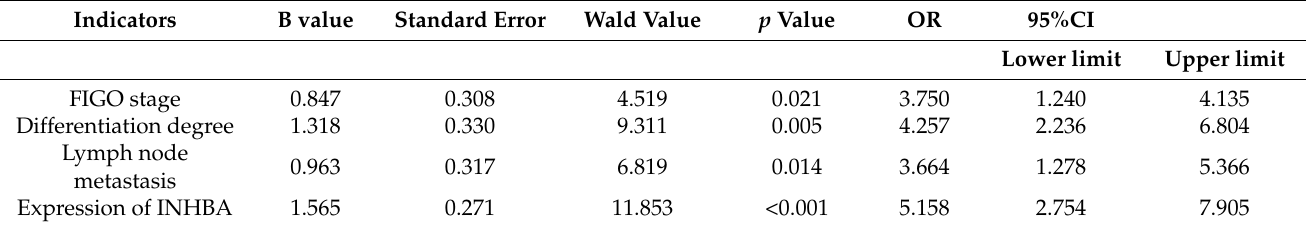
Table 5. Multivariate analysis of the clinical